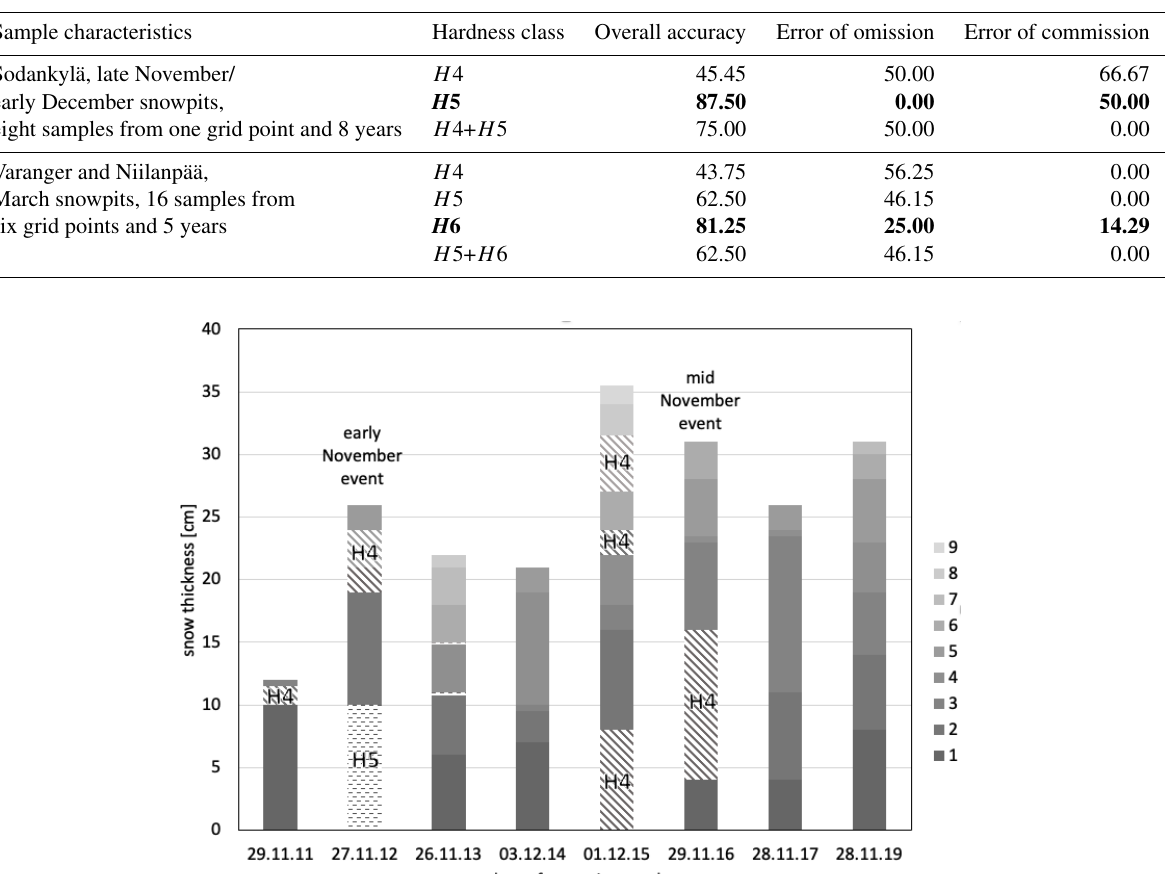
Table 3. Event detection accuracy based on snowpit records representing early winter (Sodankylä) and late winter (Varanger and Niilanpää). Differentiation by hardness class H . Minimum cumulative thickness per hardness class 1cm. Bold formatting highlights the test cases with the best results.